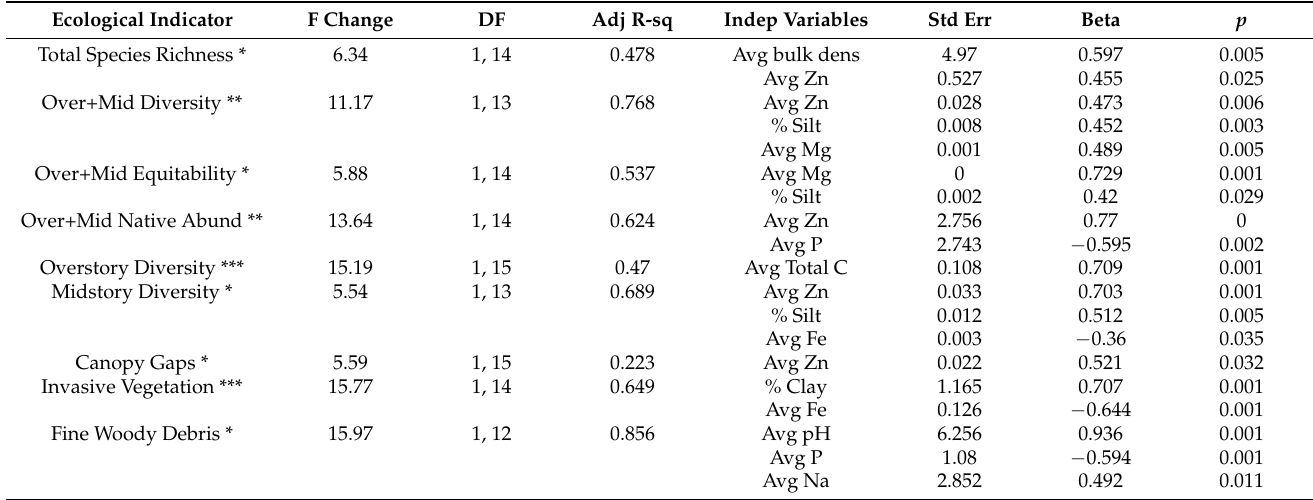
Table 2. Results of stepwise multiple regression models showing significant relationships